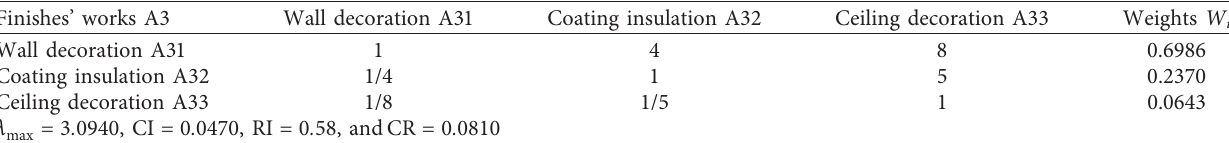
Table 7: The weight calculation matrix for finishes (A3).